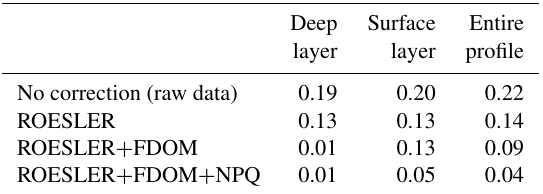
Table 1. RMSE (mgm − 3 ) comparison between HPLC measure- ments (i.e. 12 points; see Sect. 2.4 for more details) and chl a re- trieved from Fluo using different levels of correction. Deep Surface Entire layer layer profile No correction (raw